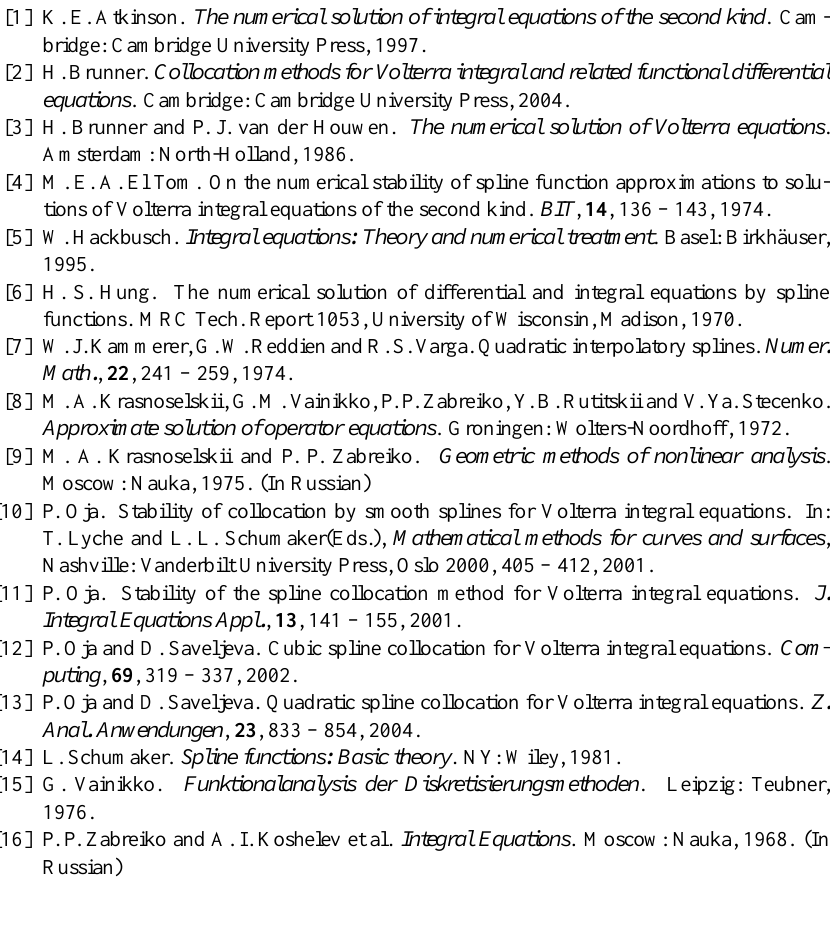
( t (cid:0) s ) y ( s ) ds + f ( t ) , nonlocal method. 0